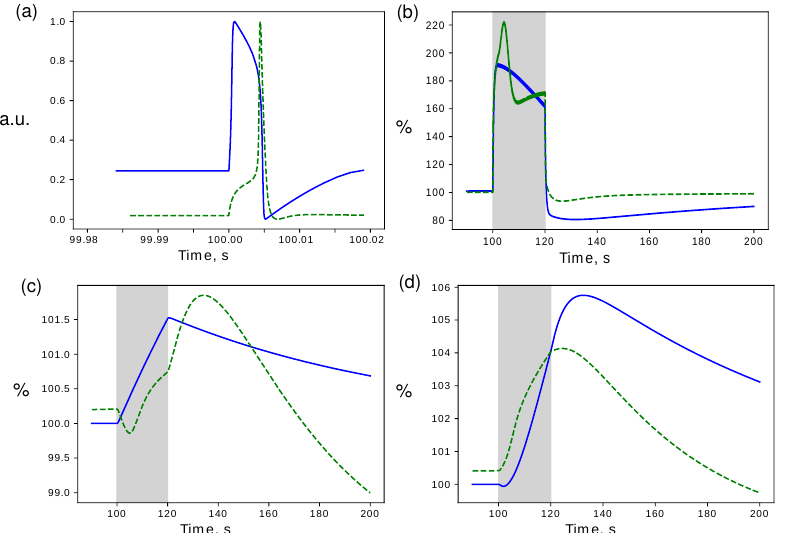
Figure 5. Time courses for counterpart variables of detailed (dashed line) and minimalistic (solid line) models, scaled to the unit interval ( a ), or relative change in % ( b – d ). ( a ) Singe spike neuron membrane potential; ( b ) Potassium concentration rise in the extracellular space; ( c ) Neuron volume change; ( d ) Astrocyte volume